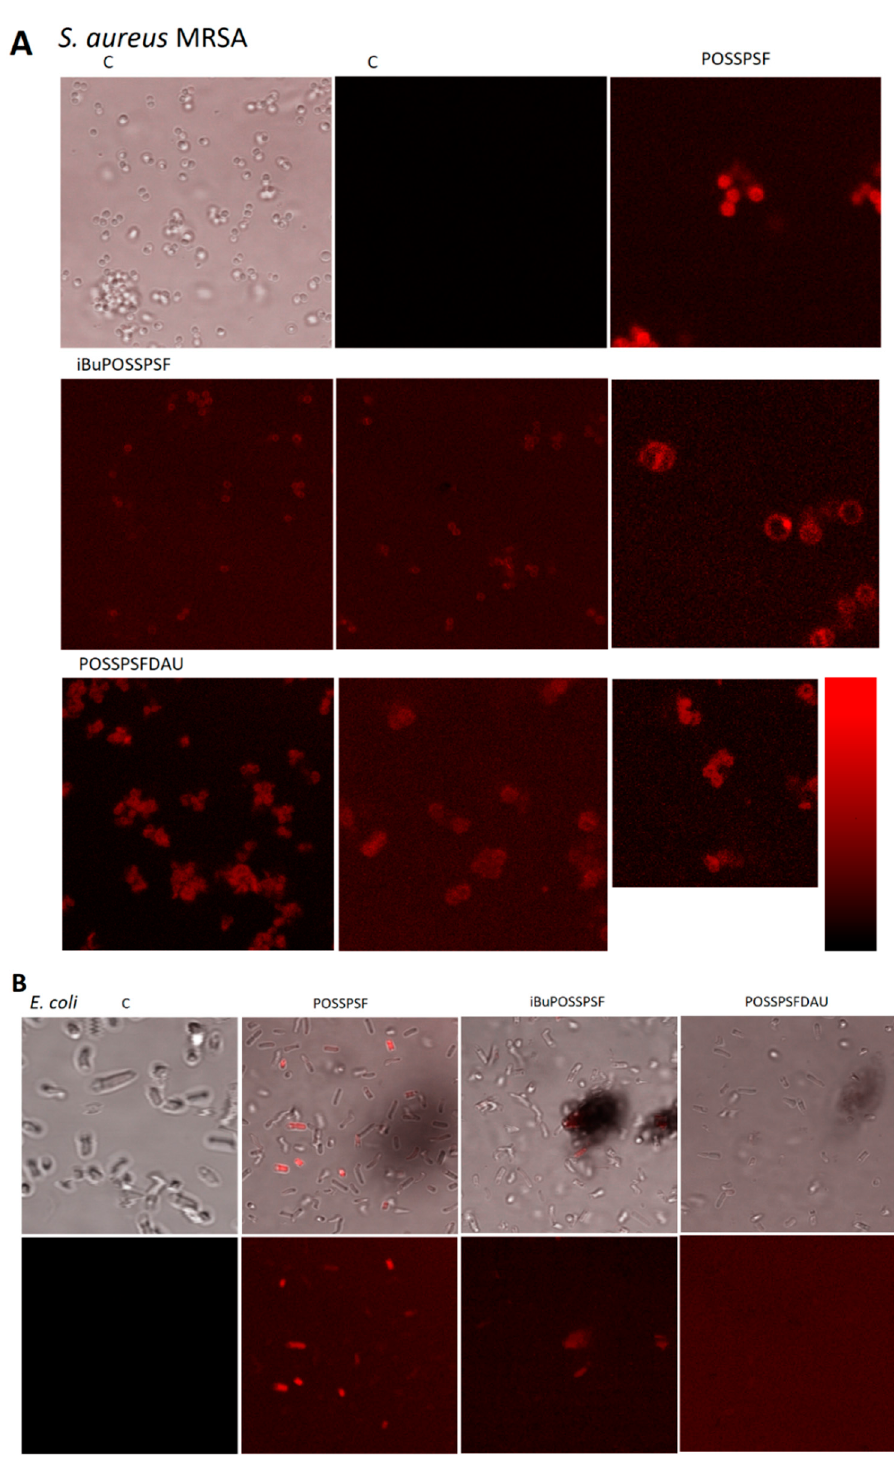
Figure 9. Confocal microscopy images of Staphylococcus aureus strain MRSA 12673 ( A ) and Escherichia coli 12519 ( B ) in the absence (control, c) and presence of POSSPSF, iBuPOSSPSF and POSSPSFDAU.